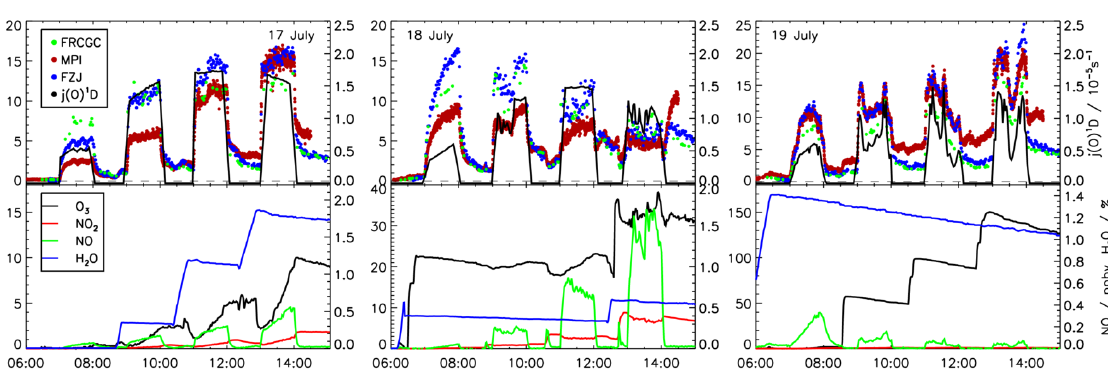
Fig. 3. Same as Fig. 2 for the first three SAPHIR chamber